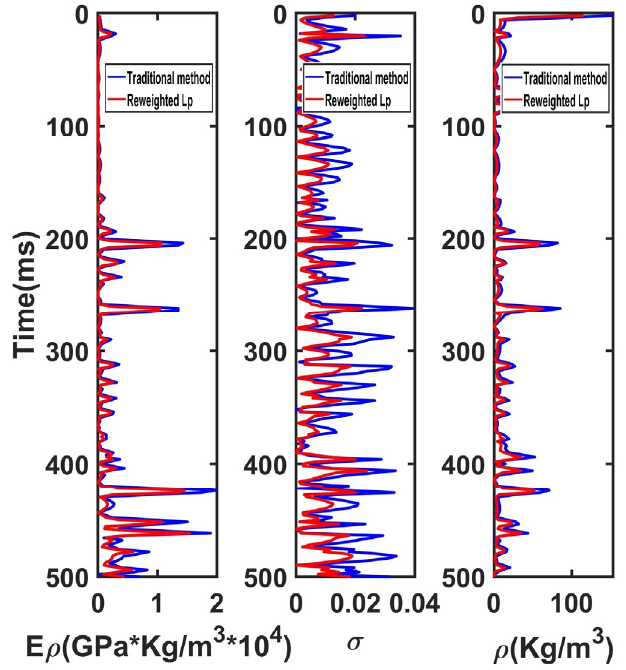
Figure 22. Comparison of inversion results for the 500th trace after adding noise.